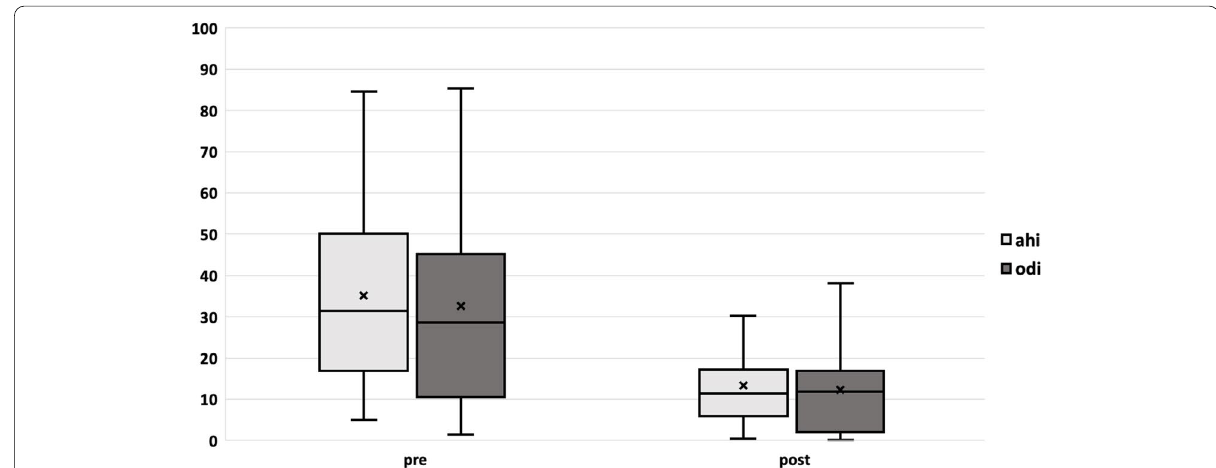
Fig. 1 AHI and ODI pre‑ and